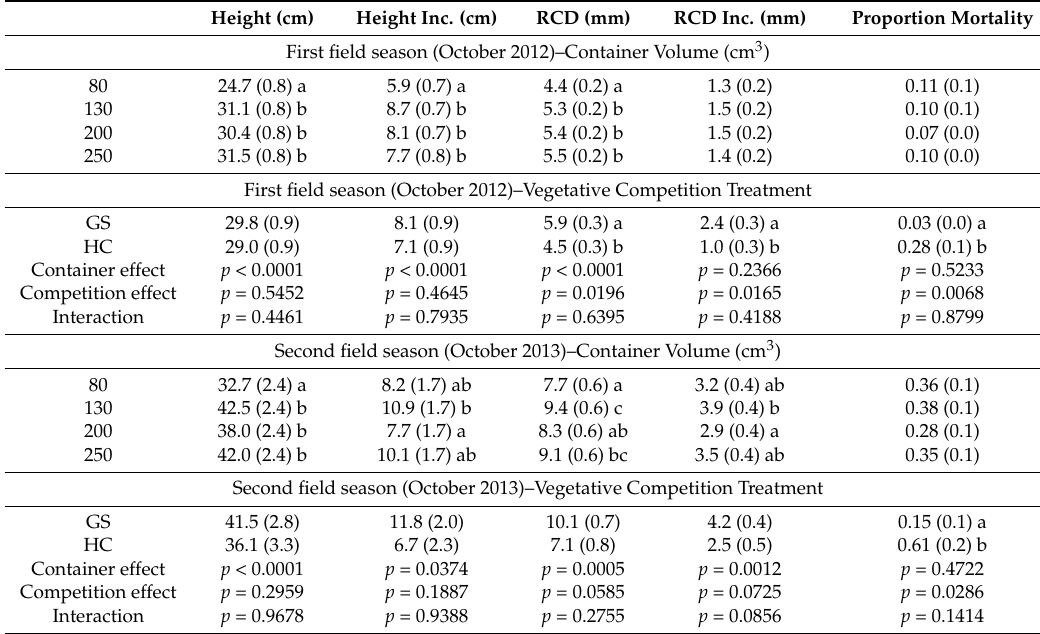
Table 3. Mean ( ± SE) height, height increment, root-collar diameter (RCD), and RCD increment of surviving Douglas fir seedlings at end of the first and second field season (October 2012 and 2013) across container types and vegetative competition treatments (GS = glyphosate-sprayed; HC = high competition). The proportion of mortality at the end of the first and second field seasons are also shown. Different letters within a field season column indicate significant differences at α = 0.05. Height (cm) Height Inc. (cm) RCD (mm) RCD Inc.